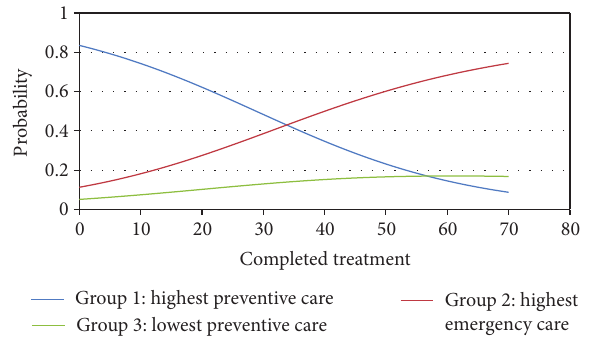
Figure 3: Probability of pertaining to each cluster according to completed treatment (more than 3 teeth with cavities and/or requiring extraction) in Belo Horizonte, Brazil,